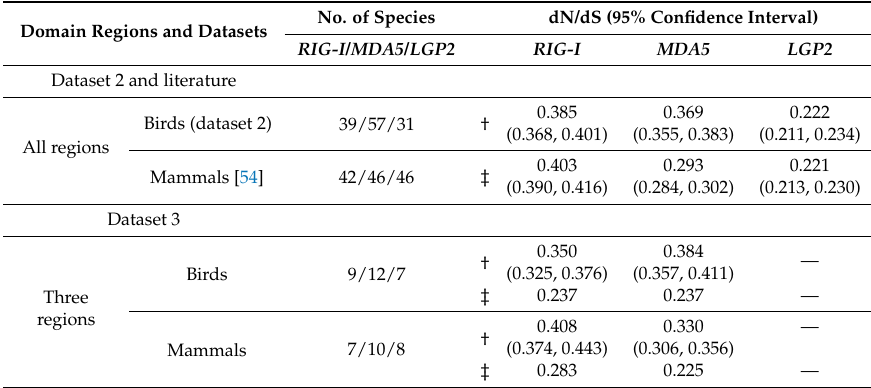
Table 2. Mean dN/dS of RLR genes in birds and